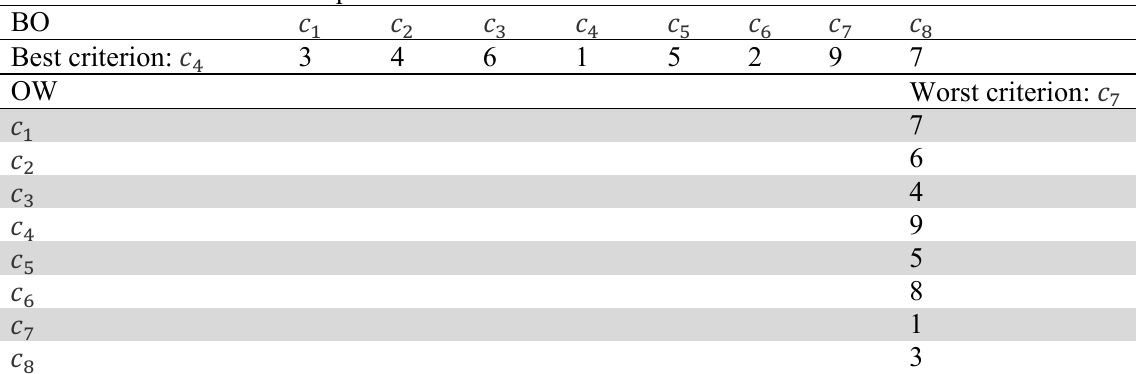
BO and OW vectors for example 4